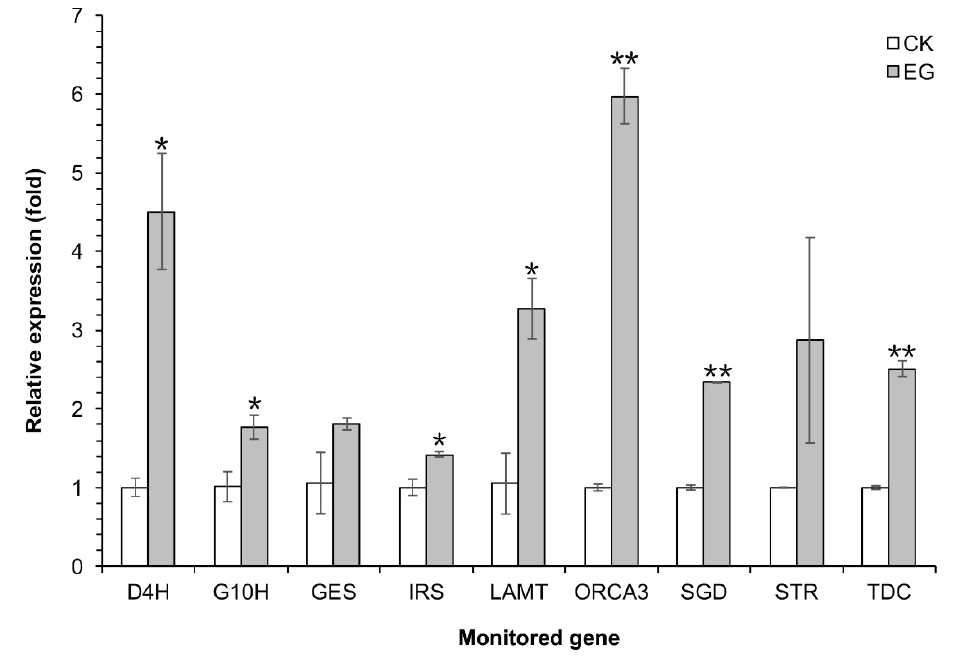
Figure 5. The effects of the A. flavus elicitor on the expression of TIA biosynthesis key genes in C. roseus CMCs under the optimal A. flavus elicitor treatment condition. C. roseus CMCs cultured under the optimal A. flavus elicitor treatment condition were labeled as the experimental group (EG). C. roseus CMCs treated by sterile water were labeled as the check group (CK). Data are given as the means ± SD ( n = 3). * p < 0.05, ** p < 0.01, compared with the CK group.